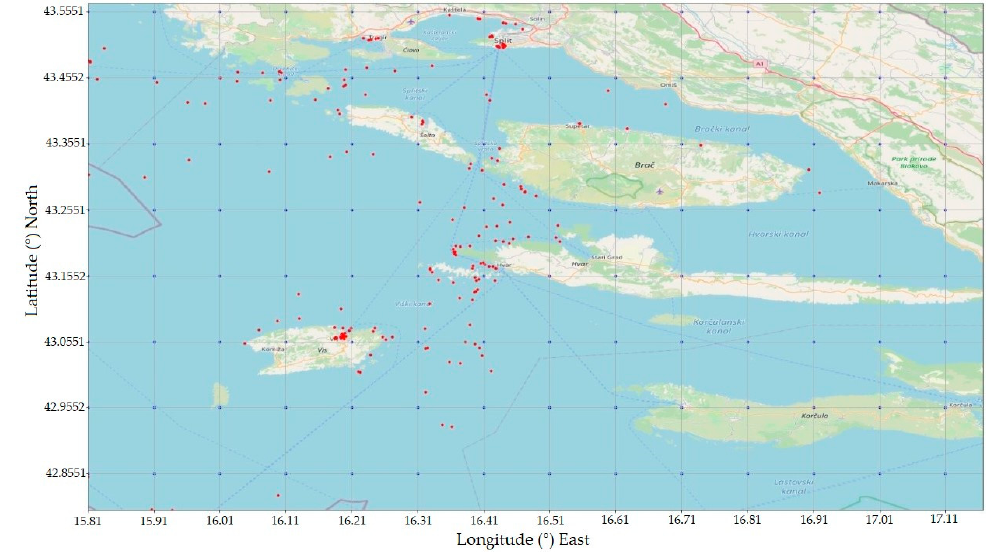
Figure 8. Cell occupation for one day.